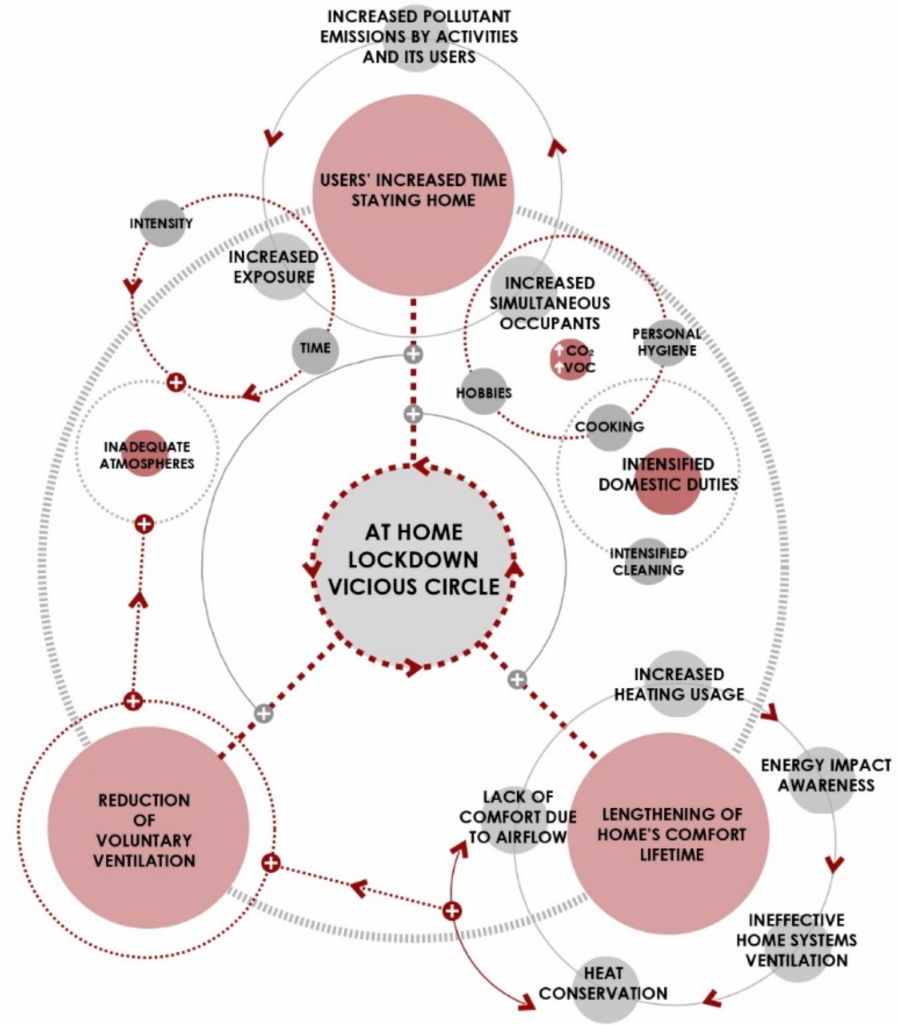
Figure 17. At home lockdown